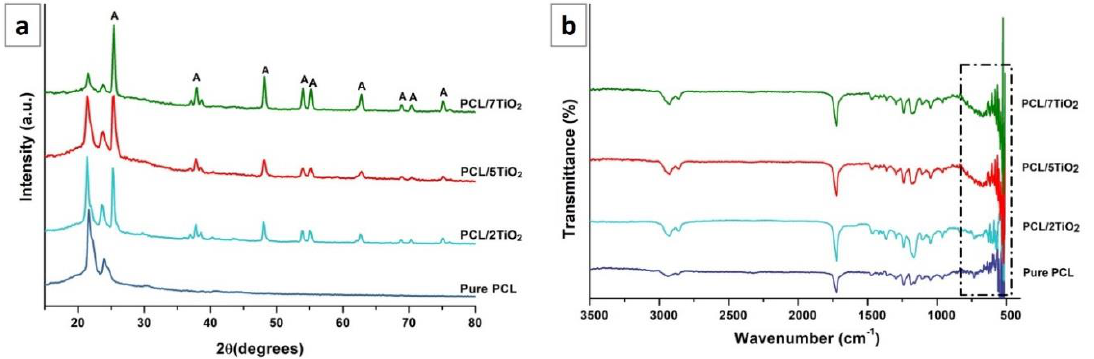
Figure 2. ( a ) XRD and ( b ) FTIR patterns of PCL/TiO 2 (2, 5 and 7 wt %) nanocomposites in comparison with pure PCL.